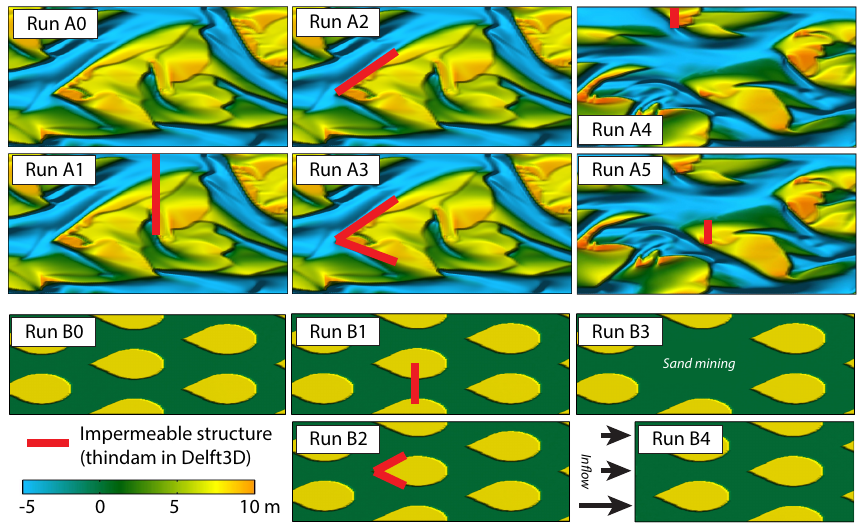
Figure 2. Model scenarios with different types of disturbance: series A with training works in the channel starting with bars from Run A0; and series B with training works and sand mining starting with droplet bars. Runs A0 and B0 are undesturbed and act as reference